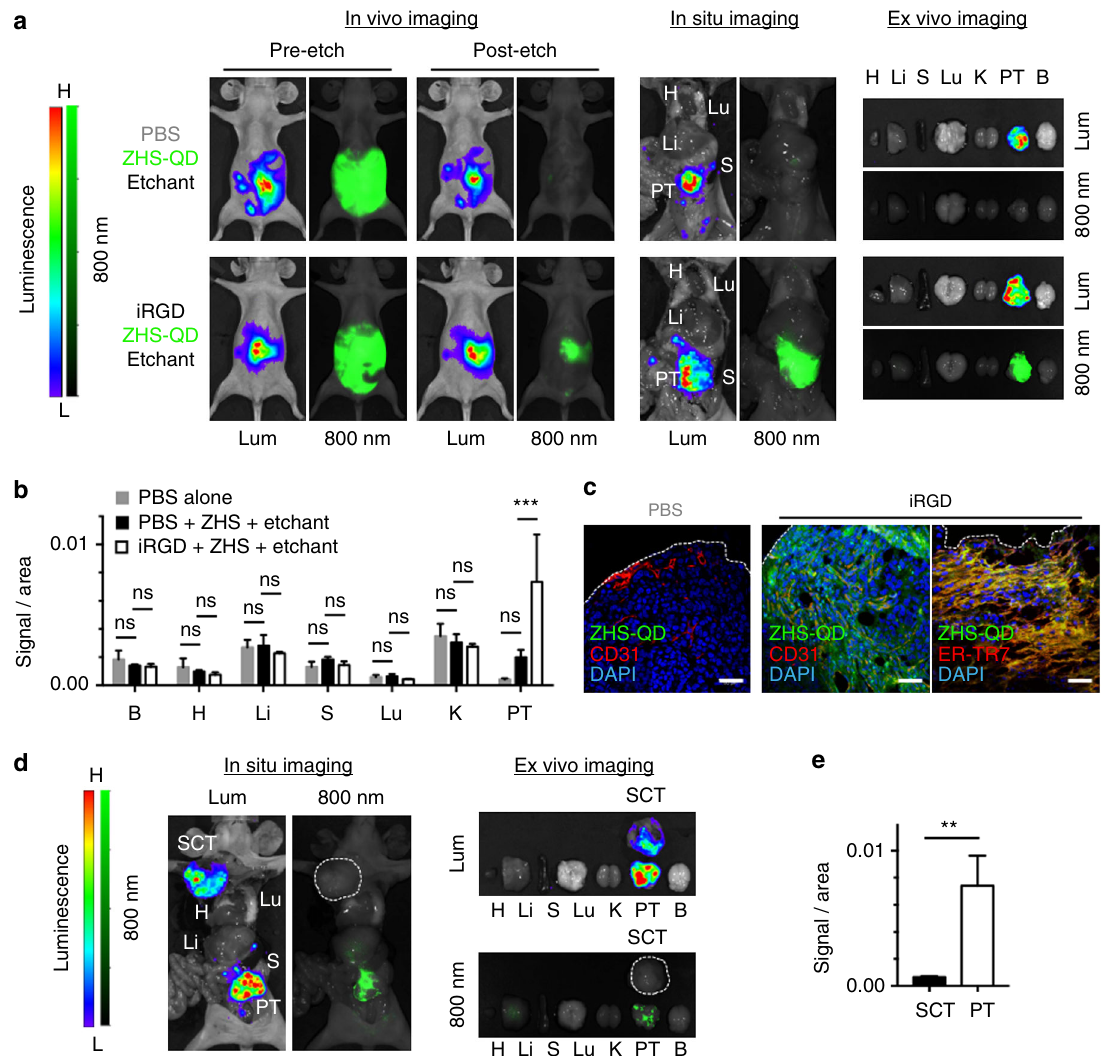
Fig. 6 Peritoneal tumor imaging with ZHS-QDs. Mice bearing peritoneal tumors (PTs) created with MKN45P-luc luciferase-positive human gastric cancer cells received an intraperitoneal co-injection of iRGD or PBS with ZHS-QDs. Intraperitoneal etchant (1x Ag-TS) was given 90 min later. n = 3 per group. Some mice carried asubcutaneous MKN45P-luc tumor (SCT) in addition to the PTs. a , d Whole body in vivo and post-necropsy in situ imaging of the tumor mice, and ex vivo imaging of resected tissues. Lum, luminescence; 800 nm, NIR. The white dotted line in d marks a SCT in a mouse that received iRGD, ZHS- QDs, and Ag-TS. b , e Fluorescent signal per unit area in collected tissues b and in SCT vs. PT in the iRGD group e . c Confocal micrographs of PTs. Blue , DAPI; red , CD31 or ER-TR7; green , ZHS-QDs; scale bars , 50 μ m. The white dotted lines indicate PT surface. B, brain; H, heart; Li, liver; S, spleen; Lu, lung; K, kidney. Statistics, two-way analysis of variance b or Student ’ s t -test e ; error bars , SEM; ns, not signi fi cant; ** P < 0.01; *** P <